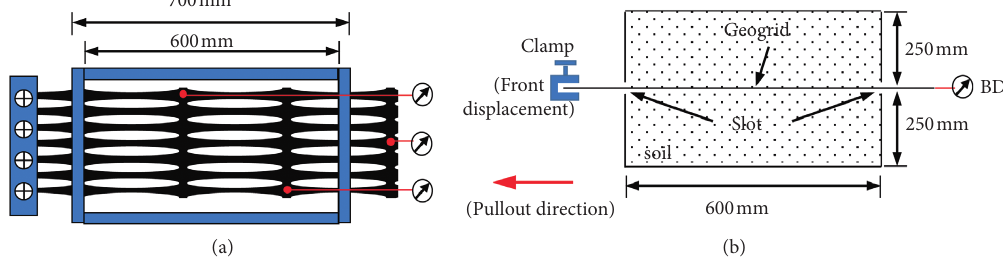
Figure 2: The view of slot and displacement meter of the pullout